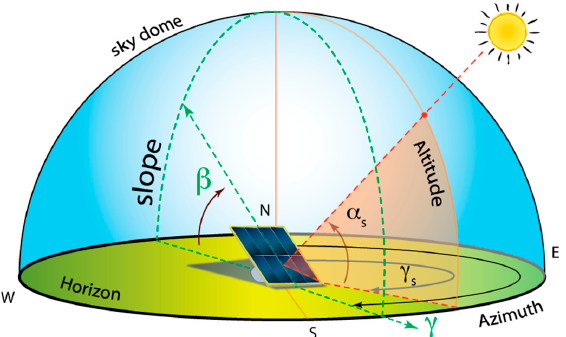
Figure 3. Fixed aperture with its orientation defined by the tilt angle ( β ) and the aperture azimuth angle ( γ ).